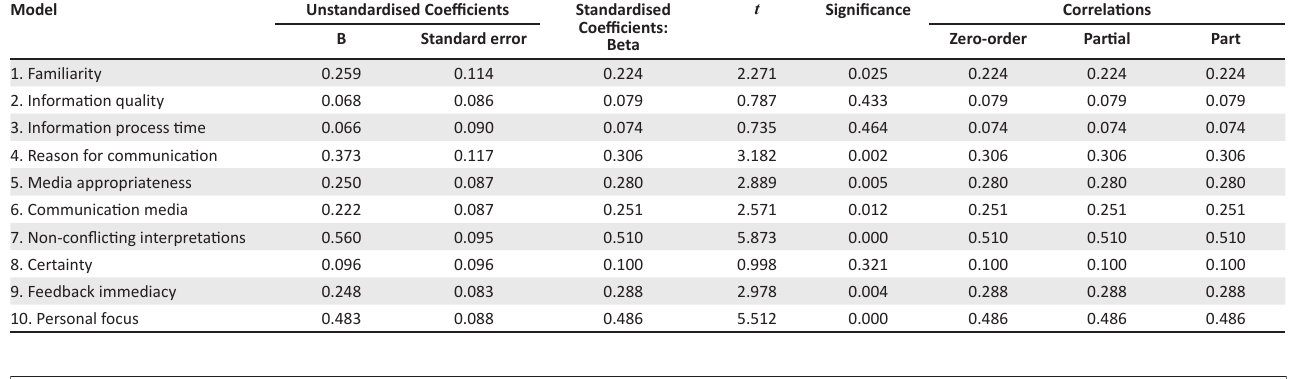
TABLE 6: Multiple regression results.